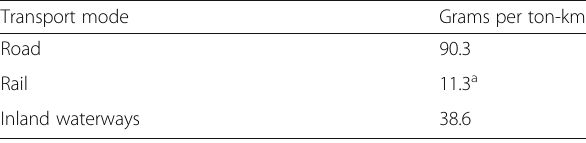
Table 9 CO 2 emission factors for